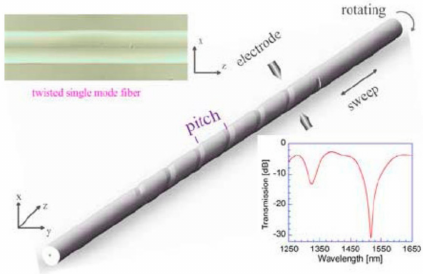
Figure 21. Schematic diagram of fabricated HLPFG in SMF [37].